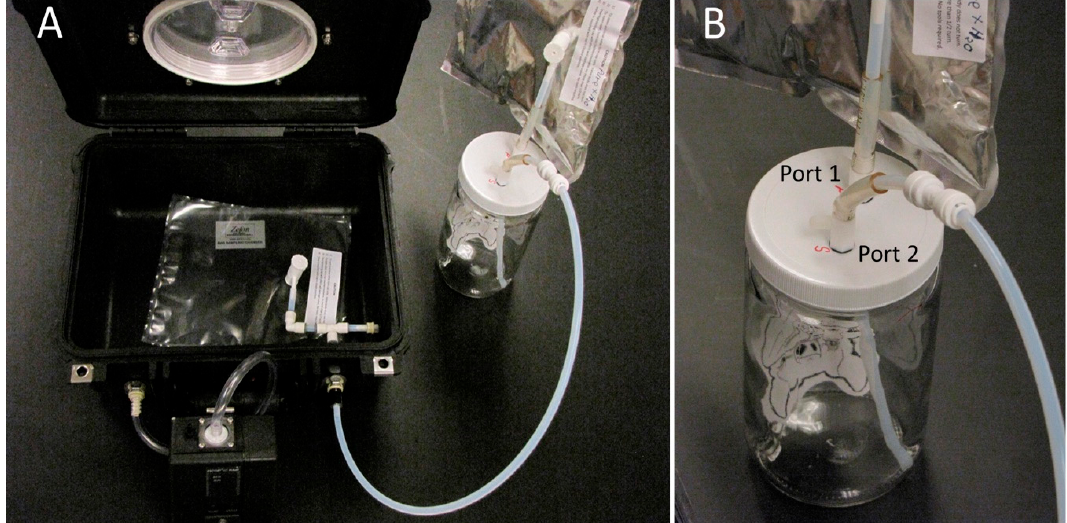
Figure 1. Bat VOC air collection apparatus assembly. ( A ) Pelican case vacuum chamber (containing PE-AL VOC air-sampling bag) with bat air-sampling chamber and Escort vacuum pump attached to vacuum chamber ports (left photo), ( B ) Close-up of bat air-sampling chamber with Port 1 (connected to pure zero-air replacement bag), and Port 2 (connected to outflow sample air tube attached to input port on Pelican case vacuum chamber (right photo).